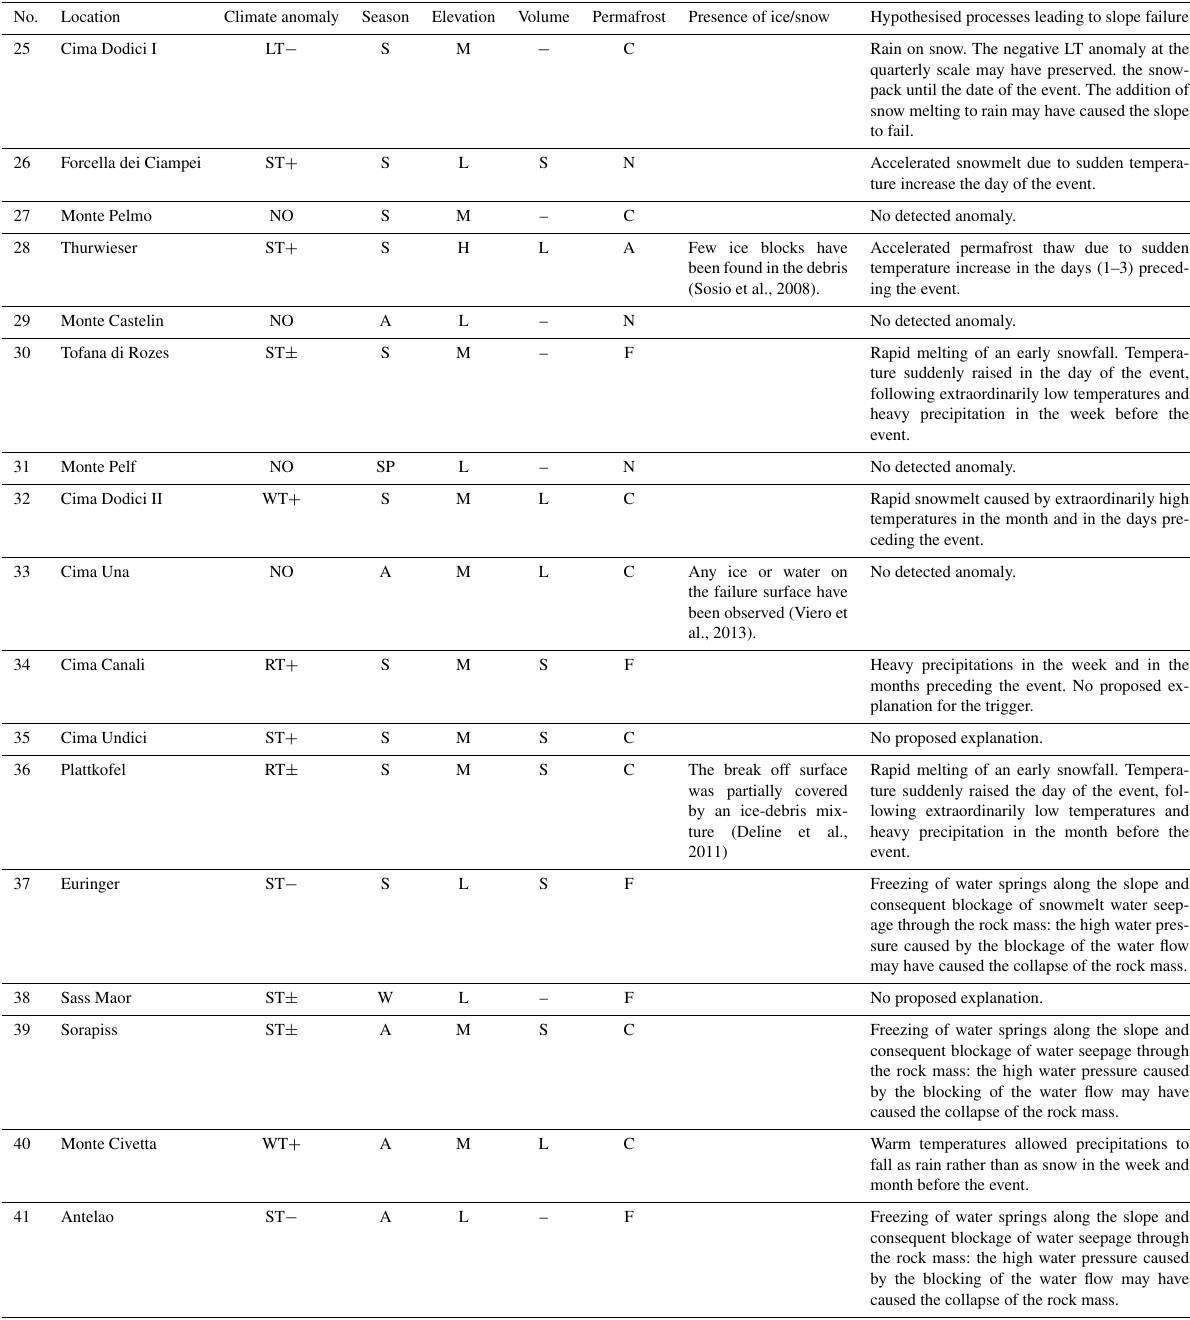
No. Location Climate anomaly Season Elevation Volume Permafrost Presence of ice/snow Hypothesised processes leading to slope failure